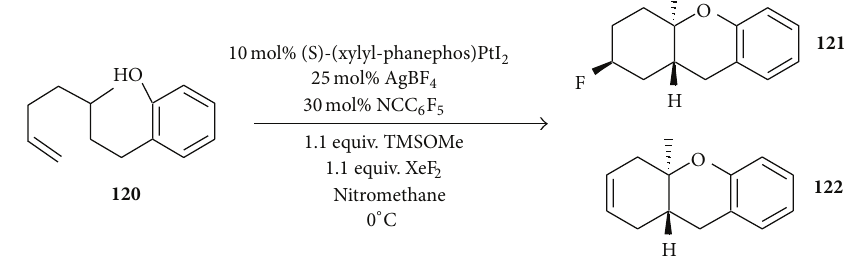
Scheme 27: Catalytic cyclization and C3-fluorination of polyene.